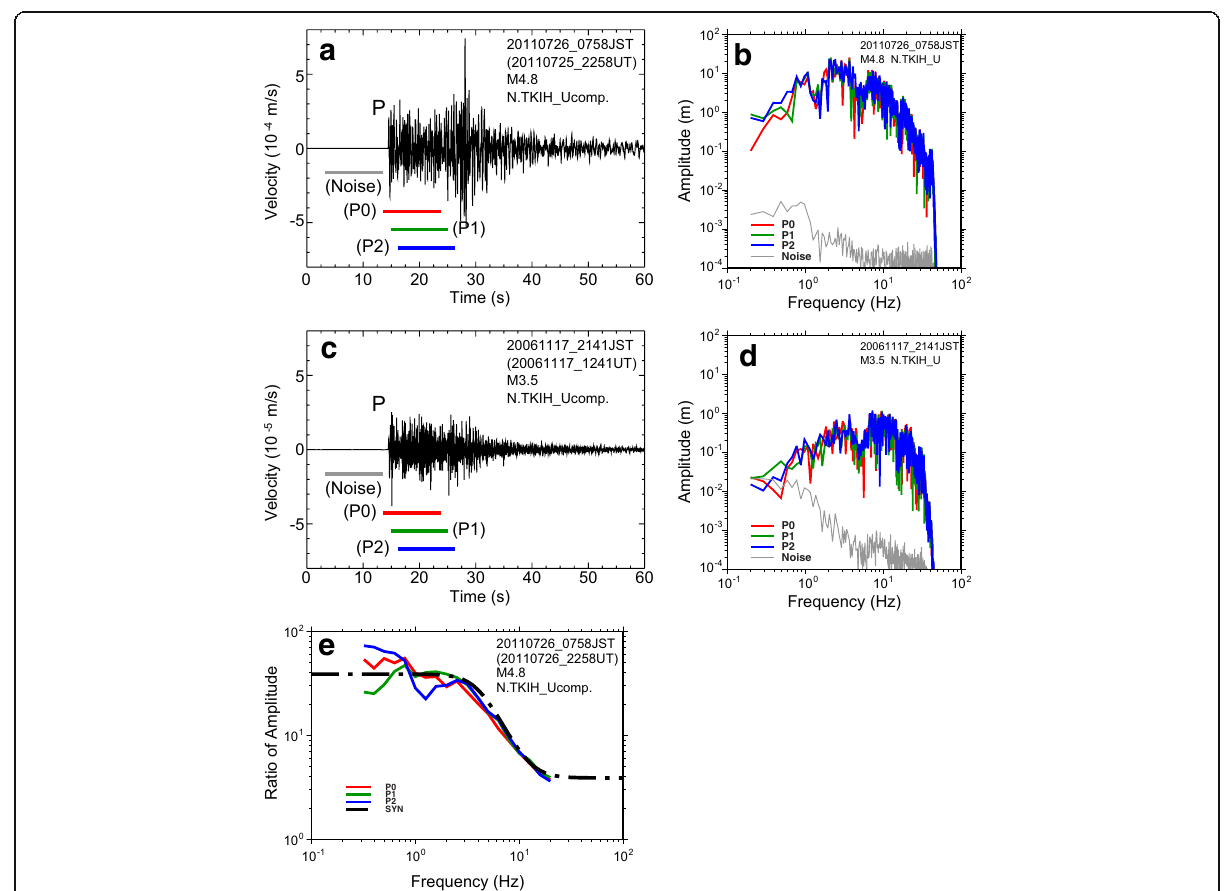
Fig. 2 a Example of an analyzed waveform of an earthquake with M4.8. The color lines indicate the three time windows used in deconvolution, which were (P0) − 0.50 to 9.73 s, (P1) 0.78 to 11.01 s, and (P2) 2.06 to 12.29 s after the P arrival. The gray line shows a time window from 12.00 to 1.77 s before the arrival time of the P wave, which was used to calculate the spectrum of a noise in ( b ). Each time window has 1024 data points. b Spectra of waveforms for the four time windows shown in ( a ). c Example of a waveform of an M3.5 earthquake that was used for an EGF. Note that the vertical scales in ( a ) and ( c ) are different. d Spectra of waveforms for the four time windows shown in ( c ). e Deconvolved spectra with the fitted omega-squared model. The color lines are deconvolved source spectra, that is, ( b ) divided by ( d ), for three individual time windows with a resampling of frequency bands. The black broken line shows the fitted omega-squared model with corner frequencies of 3.98 and 12.6 Hz for the analyzed and EGF earthquakes,